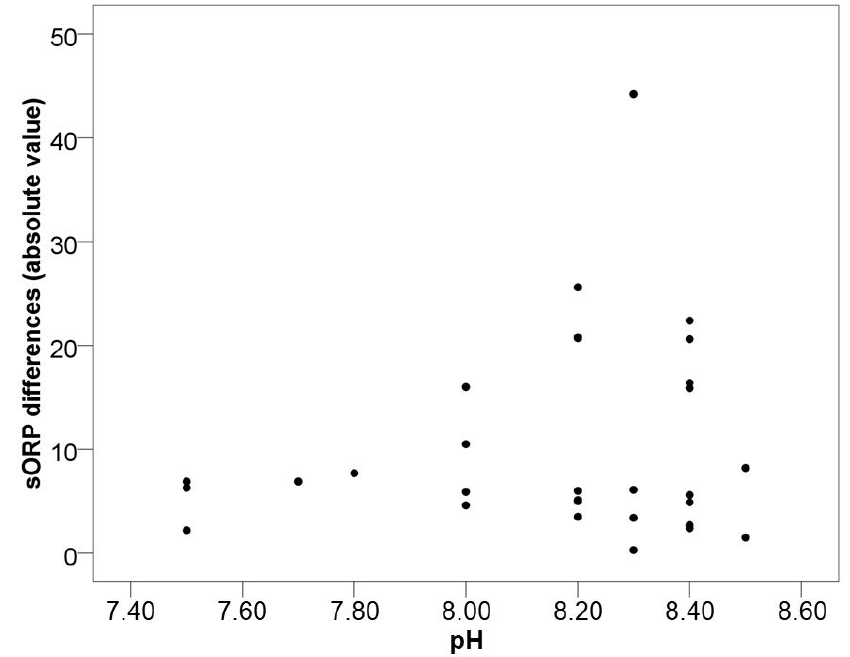
Figure 2. Distribution of di ff erences between sORP1 and sORP2 (absolute values) in idiopathic patients regarding seminal pH values of each